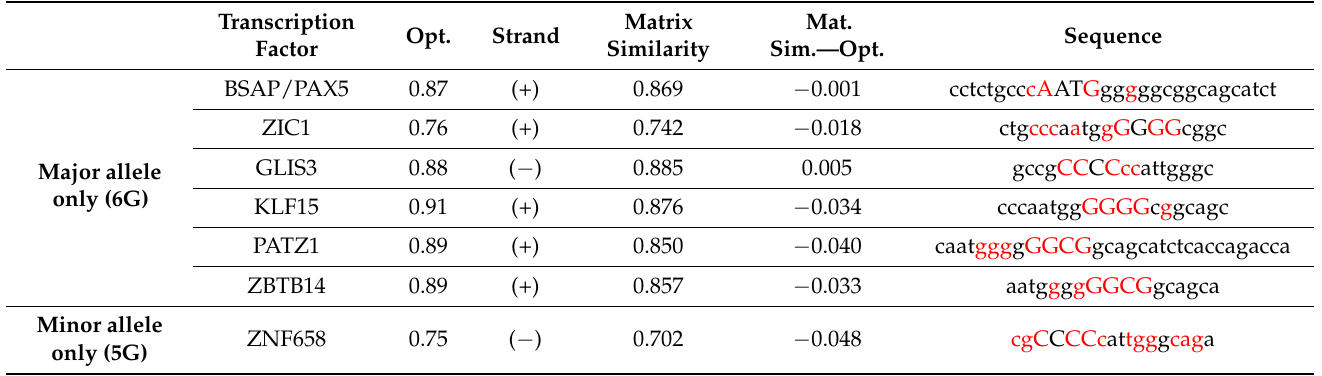
Table 3. List of transcription factors predicted to bind preferentially to the 6G or 5G allele of the rs3215788 locus ( FNTB -173 6G > 5G).